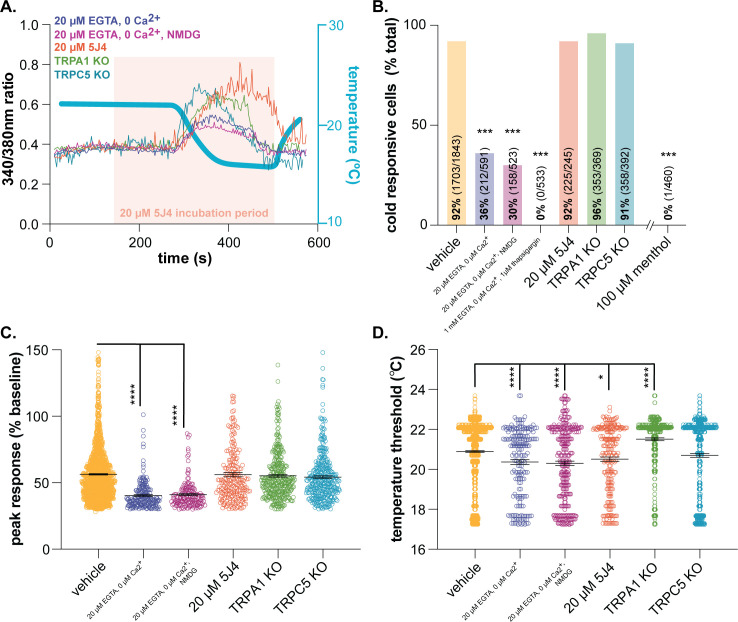
Characterizing murine cold sensor(s) in keratinocytes.(A).) In order to characterize the proteins involved in cold transduction, cold-induced calcium transients were measured in keratinocytes exposed to extracellular buffer containing different ionic concentrations or pharmacological agents, or in keratinocytes from transgenic mice. (B).) Extracellular calcium chelation (EGTA, 0 µM Ca2+) decreases the proportion of keratinocytes that respond to cold; substituting NMDG for extracellular sodium did not further decrease the percentage of cold-responsive cells. Cold responses were only abolished when endoplasmic reticulum Ca2+ stores were depleted and unable to be refilled with extracellular sources (EGTA, 0 µM Ca2+, thapsigargin). CRAC channel inhibition (5J4) did not decrease the percentage of cold-responsive cells, and similar proportions of keratinocytes from C57BL/6, global TRPA1, and global TRPC5 knockout mice responded to decreasing buffer temperature (Chi square p<0.0001; Fisher’s Exact tests ***p<0.001 vs. vehicle; n ≥ 4). (C).) Peak calcium responses to cold were lower in the absence of extracellular calcium; responses were unaltered in other conditions (1-way ANOVA p<0.0001; Bonferroni’s multiple comparisons: ****p<0.0001 vs. vehicle, #### p<0.0001 vs. EGTA, 0 µM Ca2+, &&&& p<0.0001 vs. EGTA, 0 µM Ca2+, NMDG). (D).) Altering extracellular buffer contents increased or decreased the temperature at which keratinocytes responded to cold by ≤0.6°C. Mean temperature thresholds (°C) for vehicle: 20.9, EGTA, 0 µM Ca2+,±NMDG: 20.3, 20 µM 5J4: 20.5, TRPA1 KO: 21.5, TRPC5 KO: 20.7 (Kruskal-Wallis test p<0.0001; Dunn’s multiple comparisons: *p<0.05, ****p<0.0001 vs. vehicle).